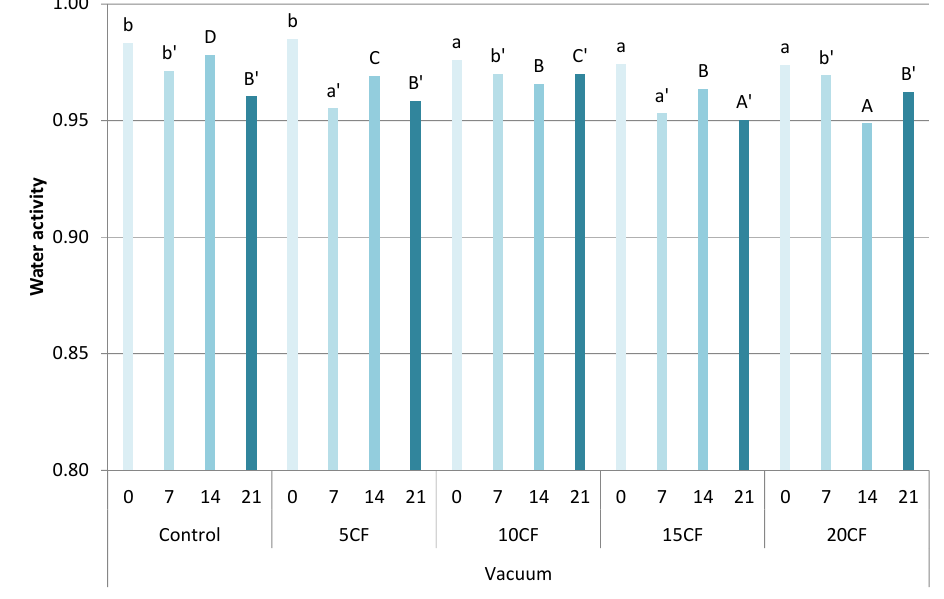
Figure 4. Water activity of gluten-free breads with the addition of chestnut flour in the amount of 5% (5CF), 10% (10CF), 15% (15CF) and 20% (20CF) after 7, 14 and 21 days of storage, packed in a barrier film with a vacuum. Values marked with the same symbols mean no statistically significant differences (α = 0.05).